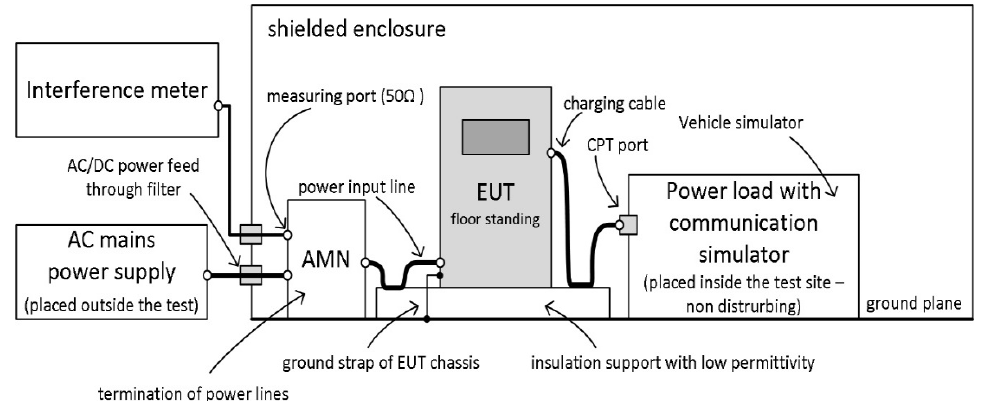
Figure 5. Diagram of the measurement system for testing conductive disturbances (EUT—equipment under test, AMN—Artificial Mains Network).